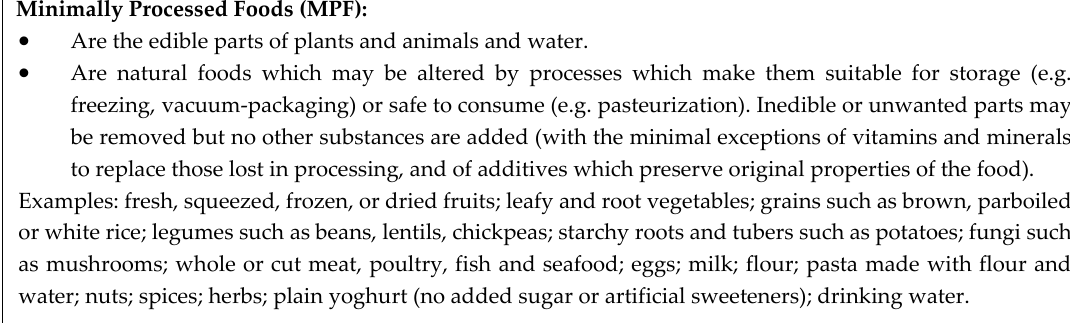
Figure 1. Criteria used to classify food frequency questionnaire (FFQ) and weighted diet record (WDR) foods into NOVA categories of food processing, developed from the work of Monteiro et al. [1,2].